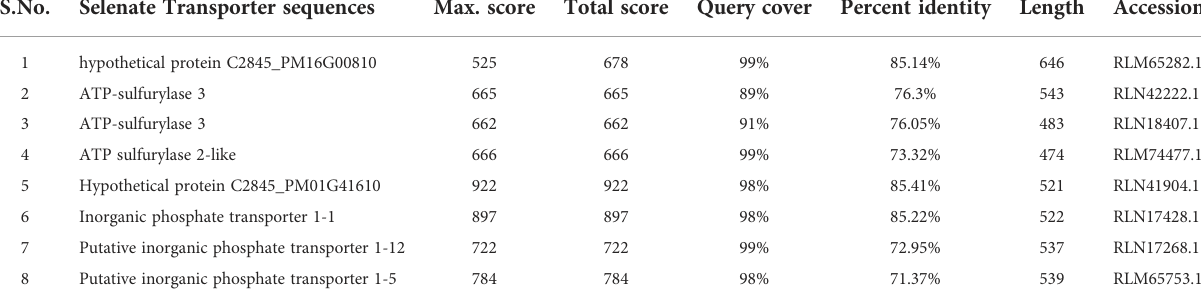
TABLE 1 Percentage identity of selenate and selenite transporter sequence from Panicum miliaceum L. with Arabidopsis thaliana L. and Oryza sativa L.